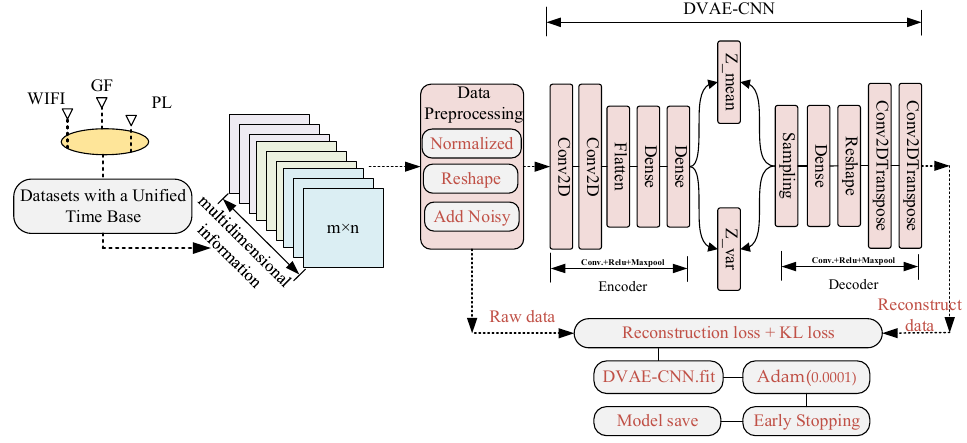
Figure 8. DVAE-CNN model construction and pre-training process.